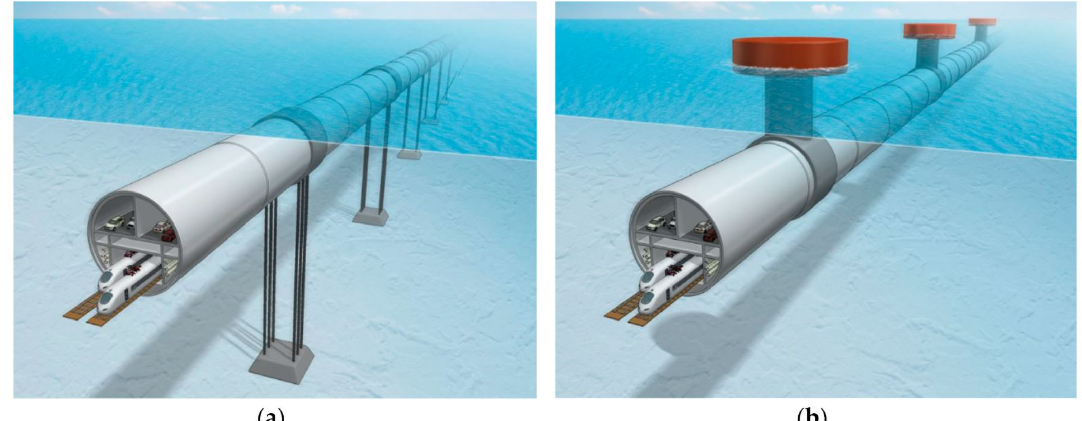
Figure 1. Two variants of an SFT